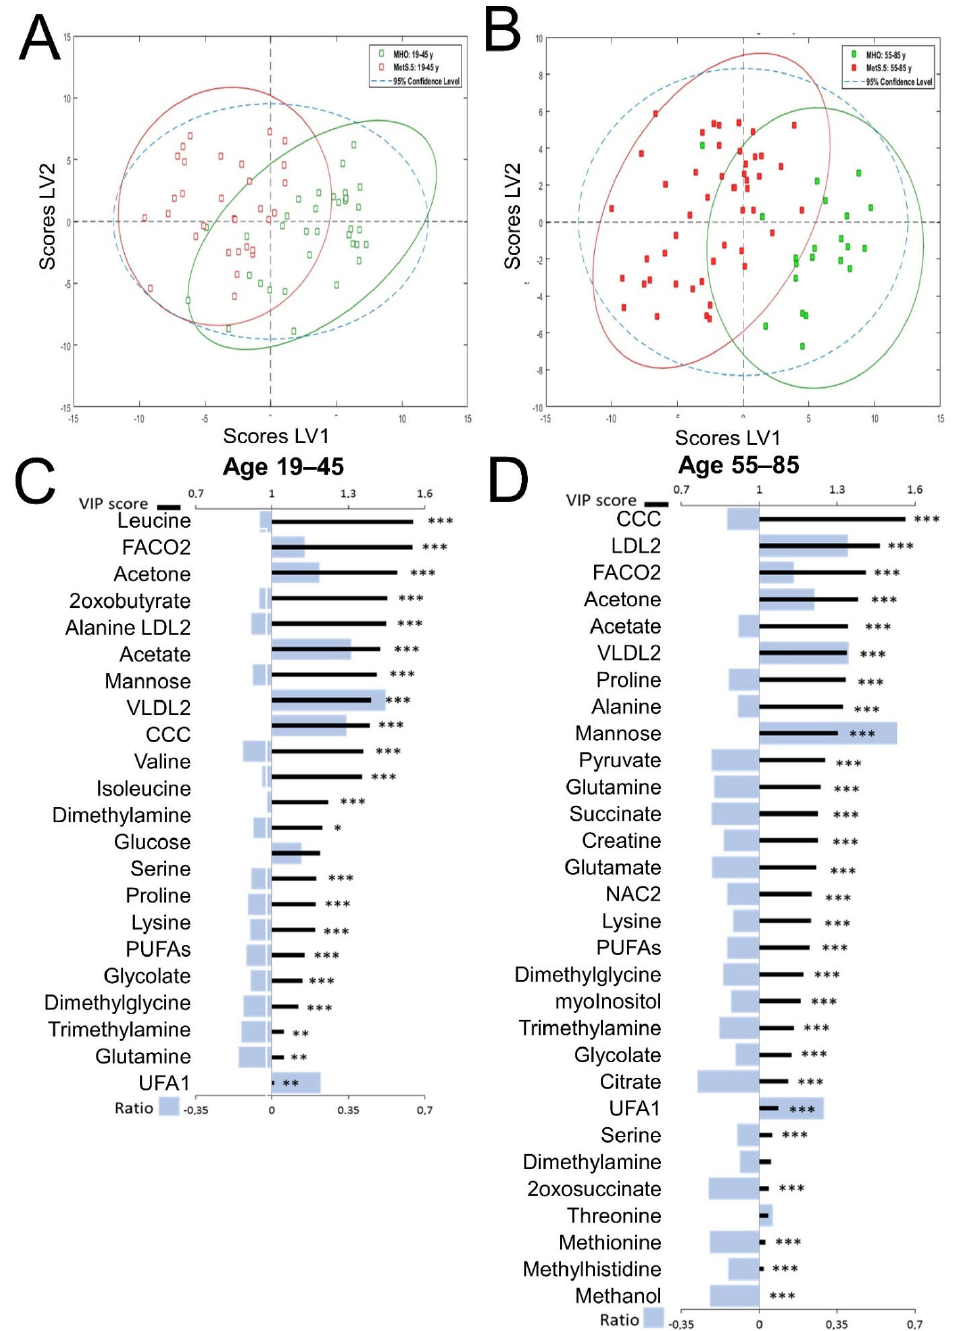
Figure 4. PLS-DA model for discrimination between MetS.5 and MHO by age range in men. All models were built using 2 latent variables (LV). All scores plots show MetS.5 samples in red and MHO samples in green with 95% confidence ellipse in the same colors. VIPs scores are represented as black thick lines (scale on the top) and relative fold change calculated as (Metabolite mean concentration of Mets.5—Metabolite mean concentration of MHO)/Metabolite mean concentration of MHO, are represented by grey bars (scale on the bottom). Significant alterations are indicated by *. Adjusted p -values (Student’s t -test corrected by Bonferroni method) to 0.00091 (*), 0.00018 (**), 0.000018 (***). ( A ). Scores plot for the age range 19 to 45 years model. Cross-validation parameters: RMSECV 0.341, R2CV: 0.534; ROC Curve AUC: 0.95. ( B ). Scores plot for the age range 55 to 85 years model. Cross-validation parameters: RMSECV 0.304, R2CV: 0.566; ROC Curve AUC: 0.95. ( C ). VIP score and relative fold change bar plot for the age range 19 to 45 years model. ( D ). VIP score and relative fold change bar plot for the age range 55 to 85 years